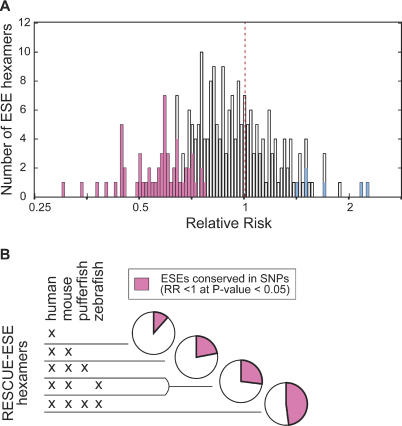
Measuring Selective Pressure on Each RESCUE-ESE HexamerAny point mutation alters six overlapping hexamers, and so a database of 8,408 SNP mutations alters a total of approximately 50,000 hexamers in the wild-type (ancestral) allele. In considering all 238 RESCUE-ESE hexamers, the frequency of each ESE hexamer in the total set of ancestral alleles was recorded for the database of SNPs and simulated mutations (8,408 SNP mutations and 100,000 simulated mutations). The ESE frequency in the SNP set was divided by the ESE frequency in the simulated set to calculate the RR for each of the 238 hexamers.(A) The distribution of RR for all 238 ESE hexamers is plotted on a logarithmic scale. A resampling strategy was used to identify 57 ESE hexamers that were significantly conserved (pink bars have an RR less than 1; p < 0.05) and also six ESE hexamers that were not conserved (blue bars have an RR greater than 1; p < 0.05).(B) The output of RESCUE-ESE was compared for several vertebrate genomes (human, mouse, pufferfish, and zebrafish). The set of 238 human RESCUE-ESE hexamers was divided into nonoverlapping subsets based on their conservation in the RESCUE-ESE output generated from other vertebrates. The proportion of ESEs that were significantly conserved in the SNP analysis (as described above in [A]) were recorded for each subset of RESCUE-ESE hexamers and are represented as pink sectors in the pie chart.